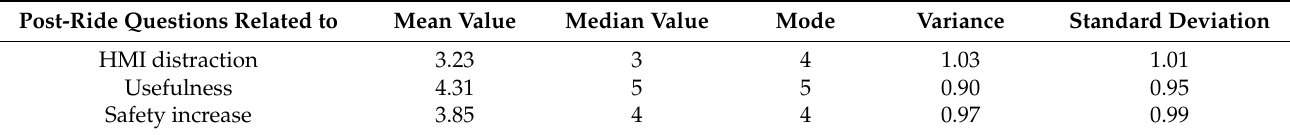
Table 2. The results from post-ride questionnaires including specific questions on general and the use-case Public Transport Vehicle Crossing.